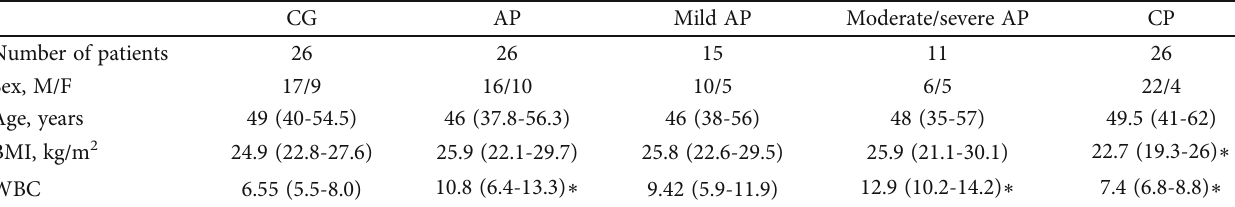
Table 2: General and clinical characteristics of the patients enrolled in the study. CG